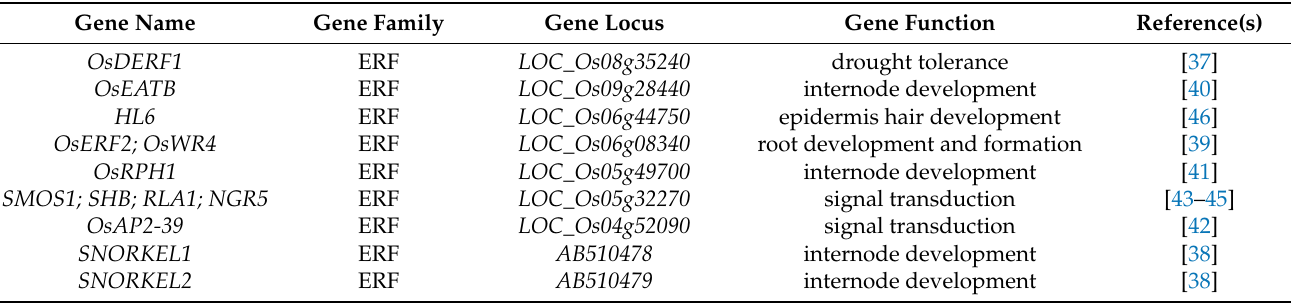
Table 7. Genes associated with hormone regulation in